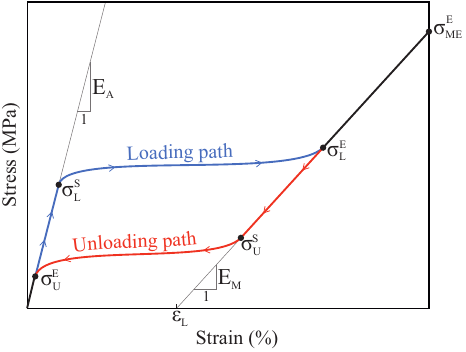
Figure 2. Sample stress–strain curve for NiTi